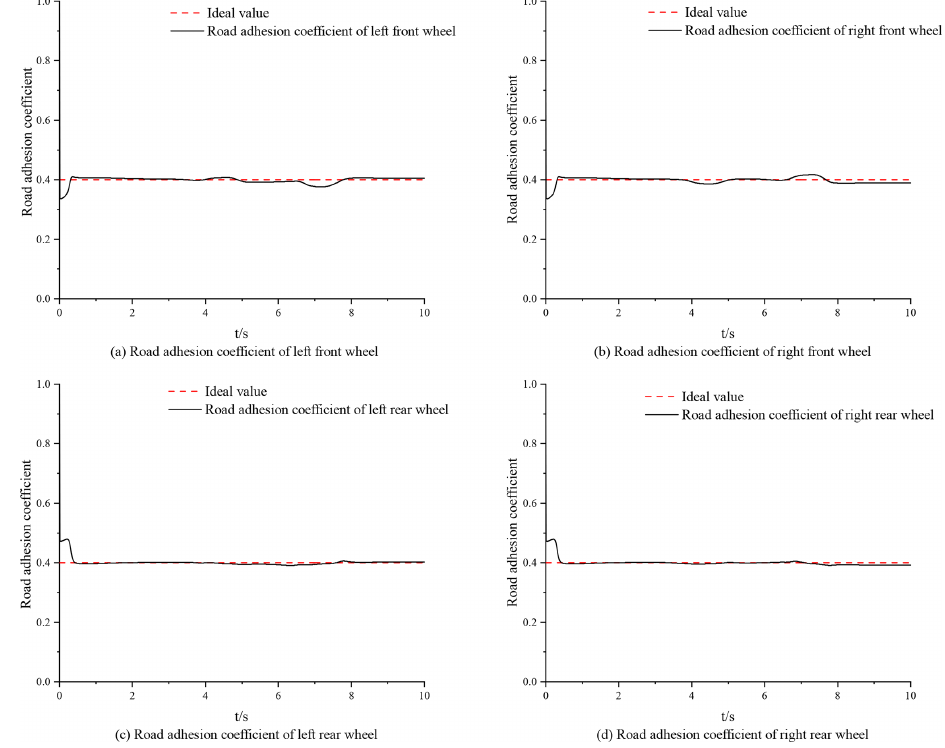
Figure 7. The low-adhesion road surface identification effect based on the UKF algorithm.